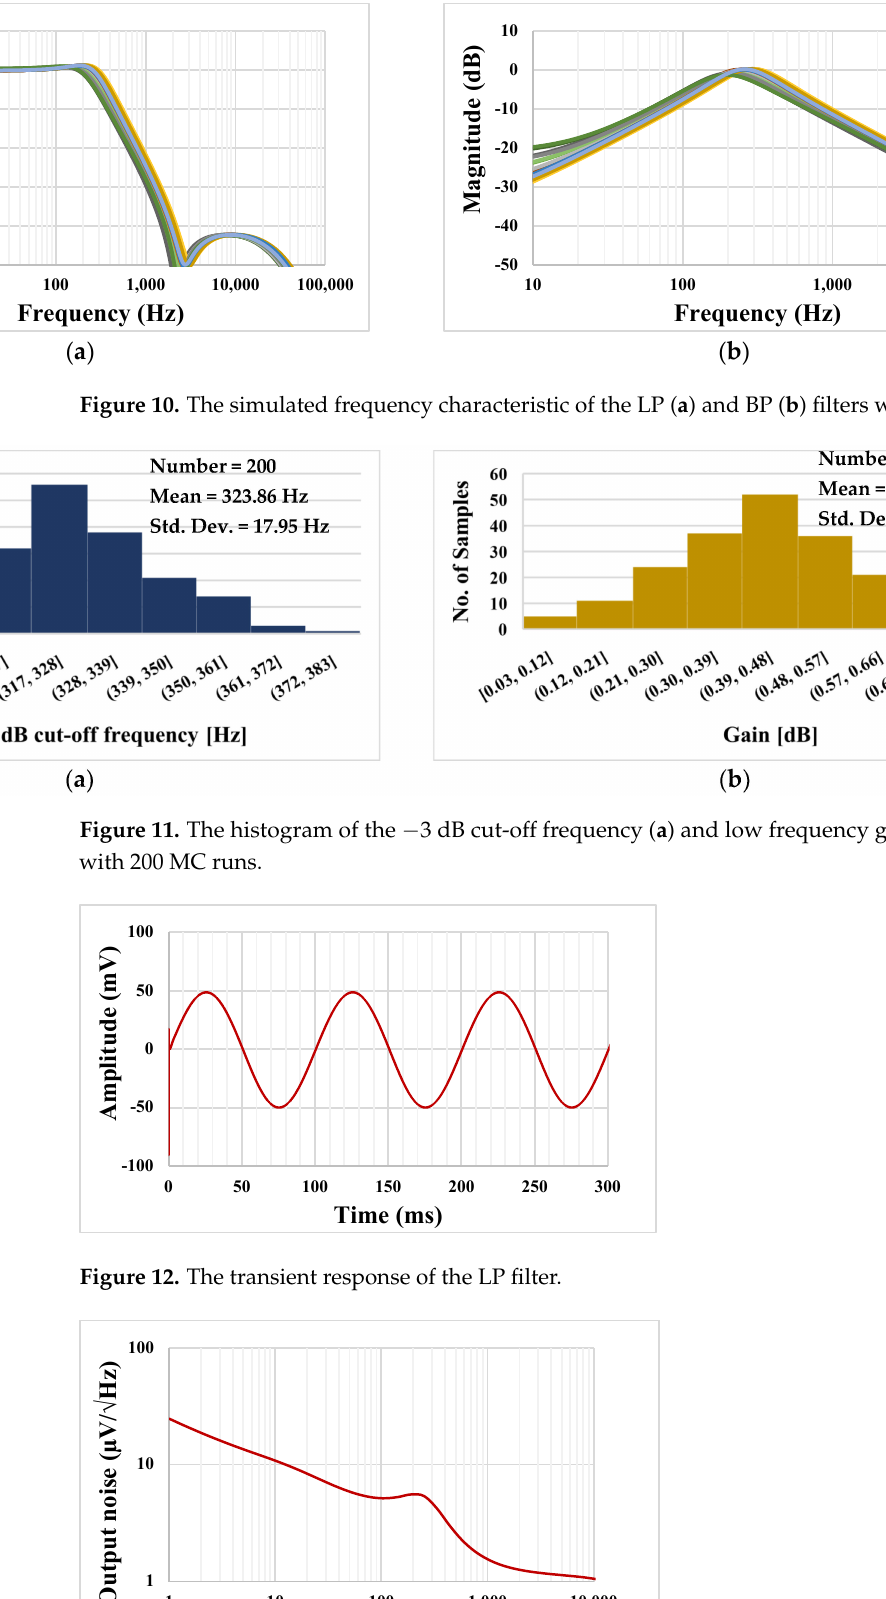
Figure 12. The transient response of the LP filter. Figure 13. The output noise the LP filter. Figure 13. The output noise the LP